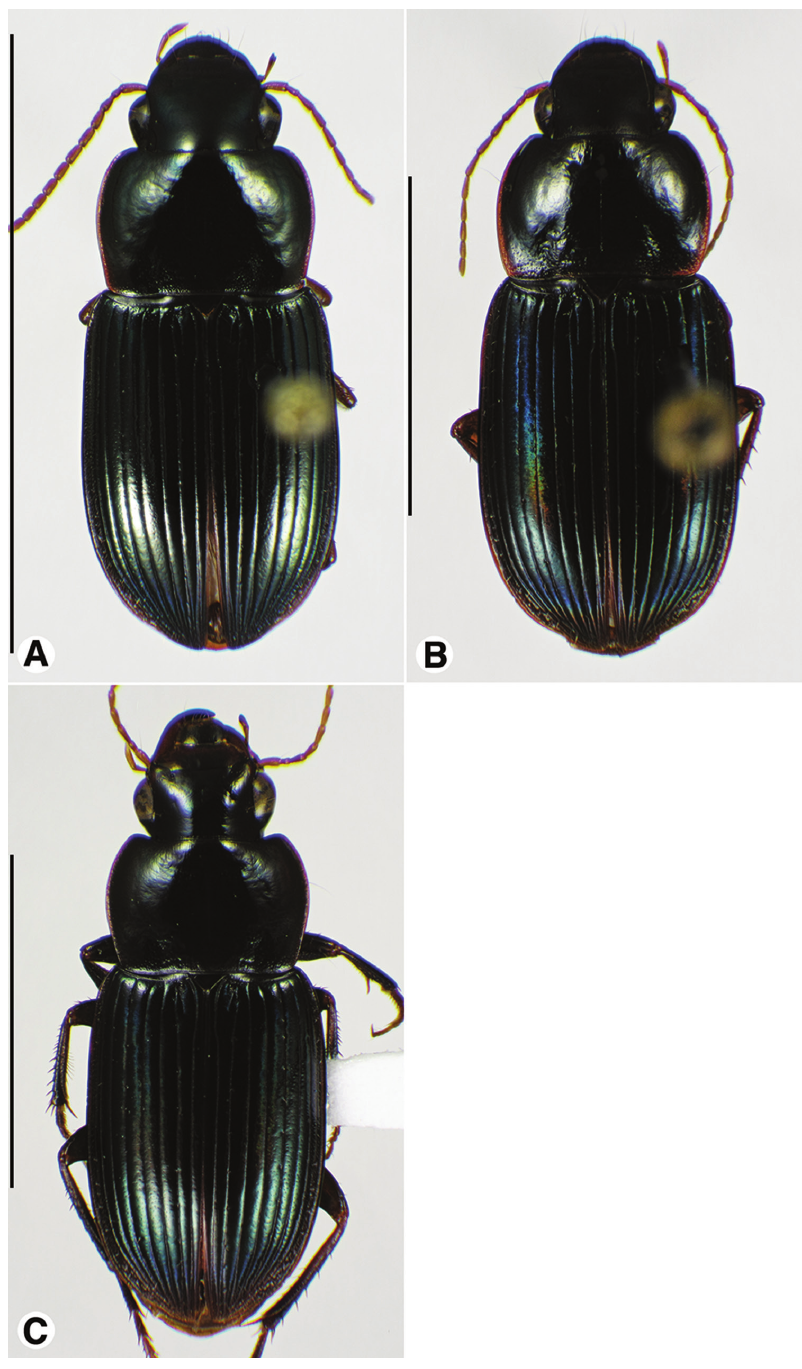
Figure 40. Habitus digital images of Selenophorus opalinus species group, in part, dorsal aspect. A S. integer (Fabricius) B S. opalinus LeConte C S. propinquus Putzeys. Scale bars: A 10 mm; B, C 5